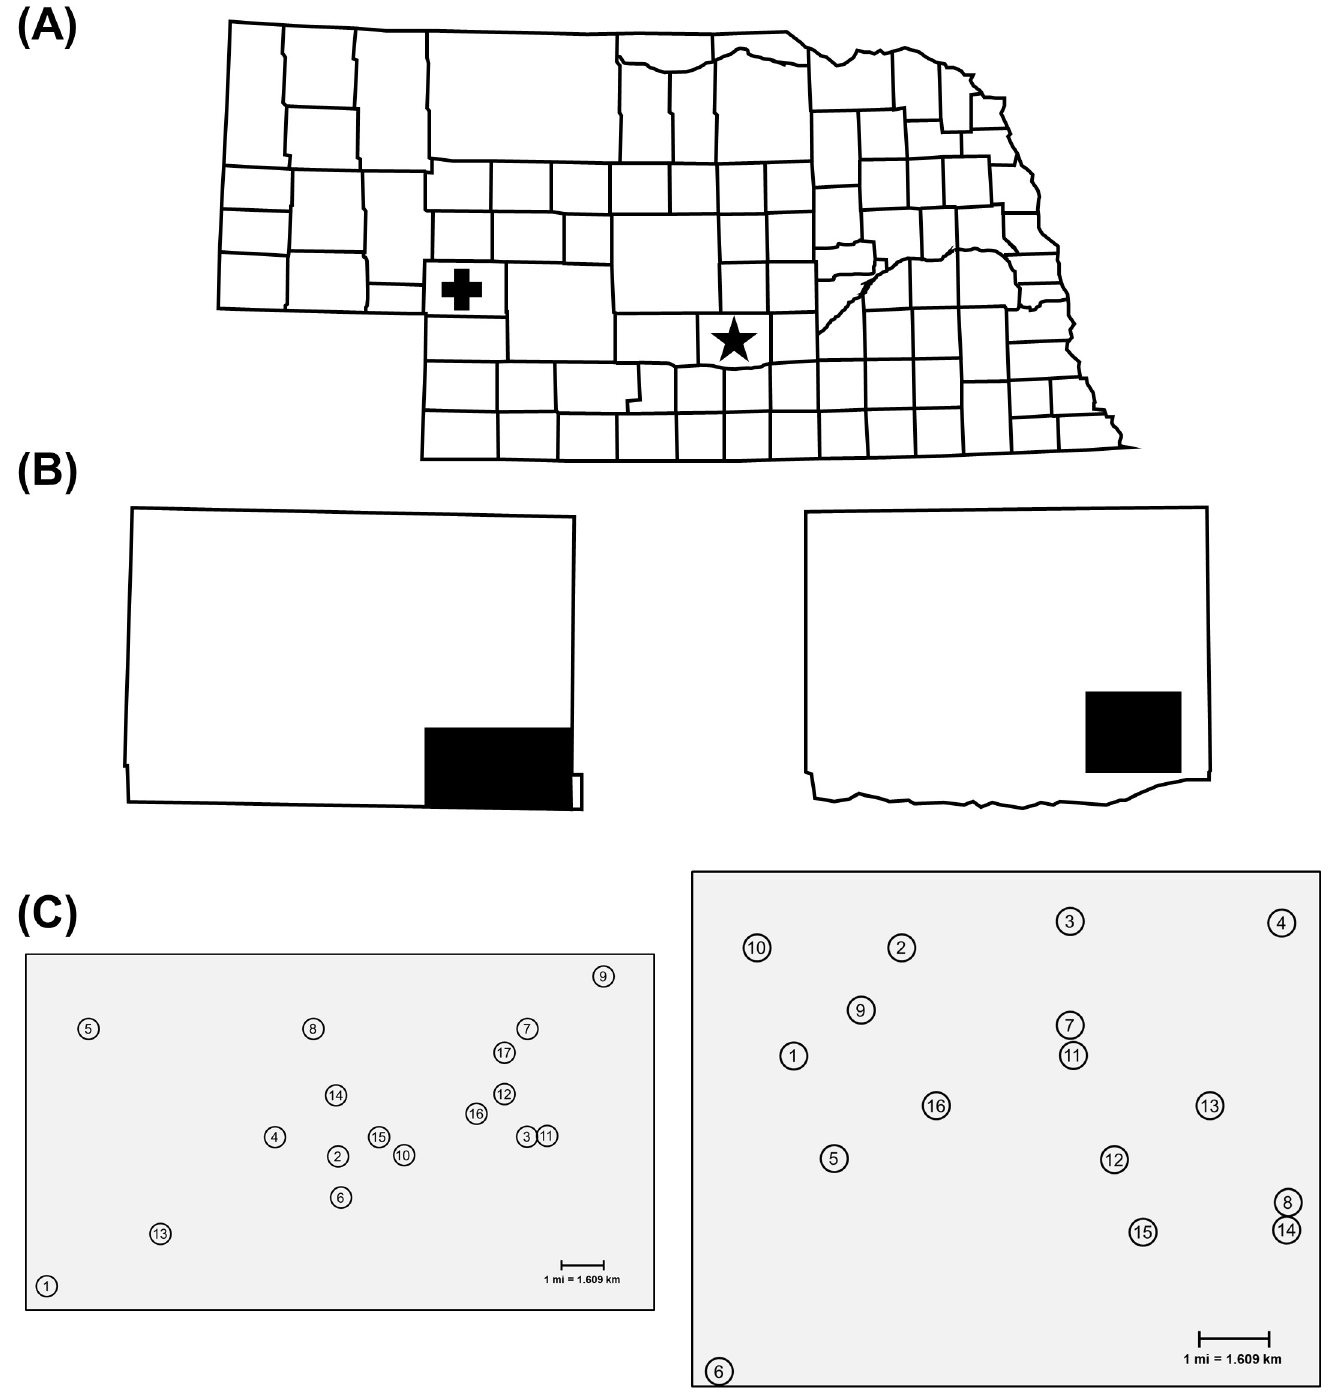
Fig 1. Sampling grid system established in two Nebraska counties. (A) County map of the state of Nebraska showing location of Keith County (+) and Buffalo County ( � ). (B) Areas of Keith County (left) and Buffalo County (right) where sampling grids were established. (C) Spatial distribution of sampling sites in Keith County (left) and Buffalo County